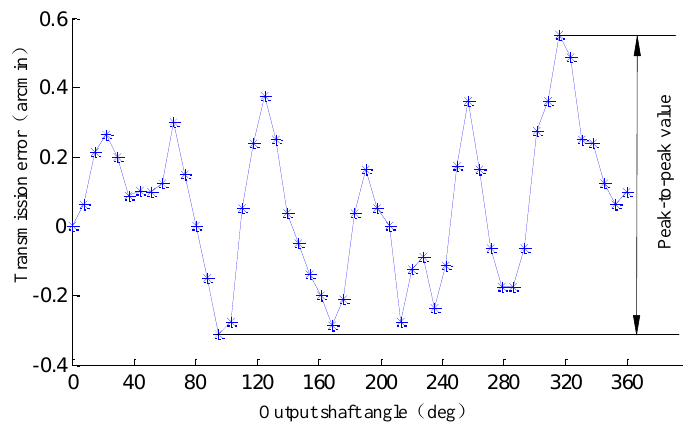
Figure 1. Transmission error curve.